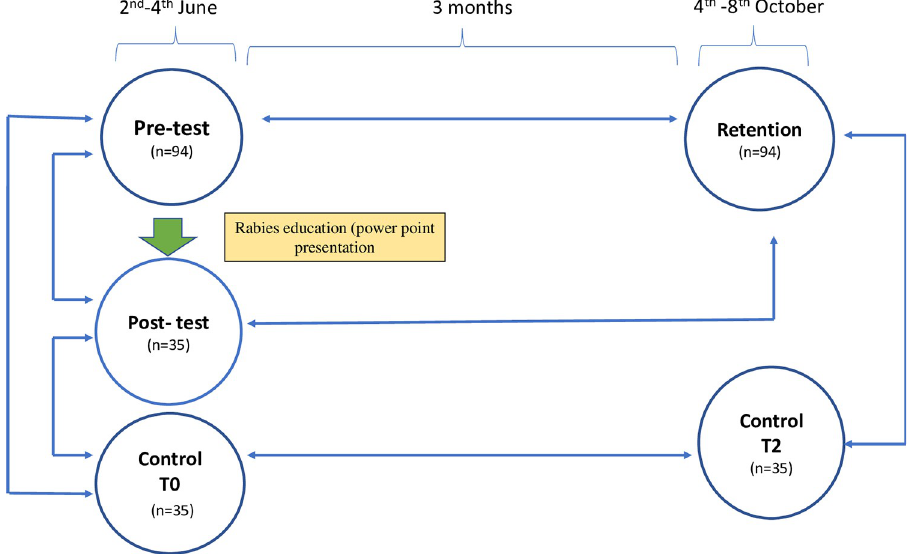
Fig 2. Schematic diagram of data collection, educational intervention and data analysis. The pre-test represents the data collection before educational intervention, post-test correspond to data collection immediately after intervention (after power point presentation on rabies) and retention correspond to the data collection at three months time period at after intervention. Control T0 and Control T2 refers to data collection from control group on day 0 (Control T0) and at three months time period (Control T2). The data collection from the control group was also done at the same time of intervention group. The numerical figures refer to the number of students participated in the survey in each study group at different time